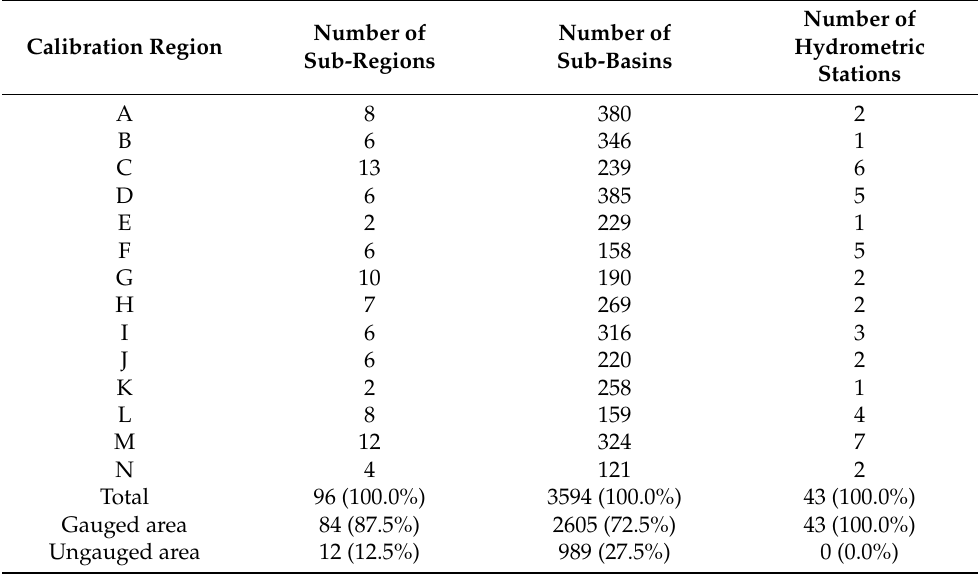
Table 4. Resume of calibration regions delimited for the study area, including gauged and ungauged